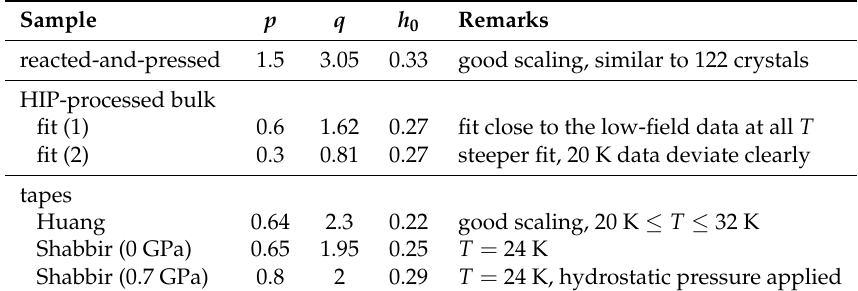
Table 1. Fitting parameters and peak positions of the DH scaling of various 122 sample types. For the references, see the main